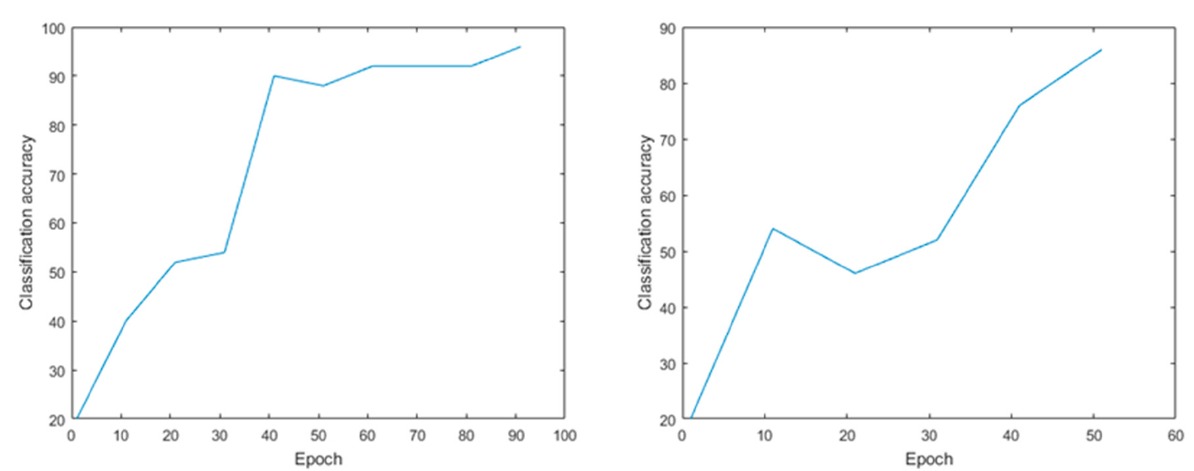
Figure 3. DBN model. Note: The accuracy rate of the method reached 96.12% after 100 iterations and the average error was 3.88%; it was 84.21% after 55 iterations and the average error was 15.79%.